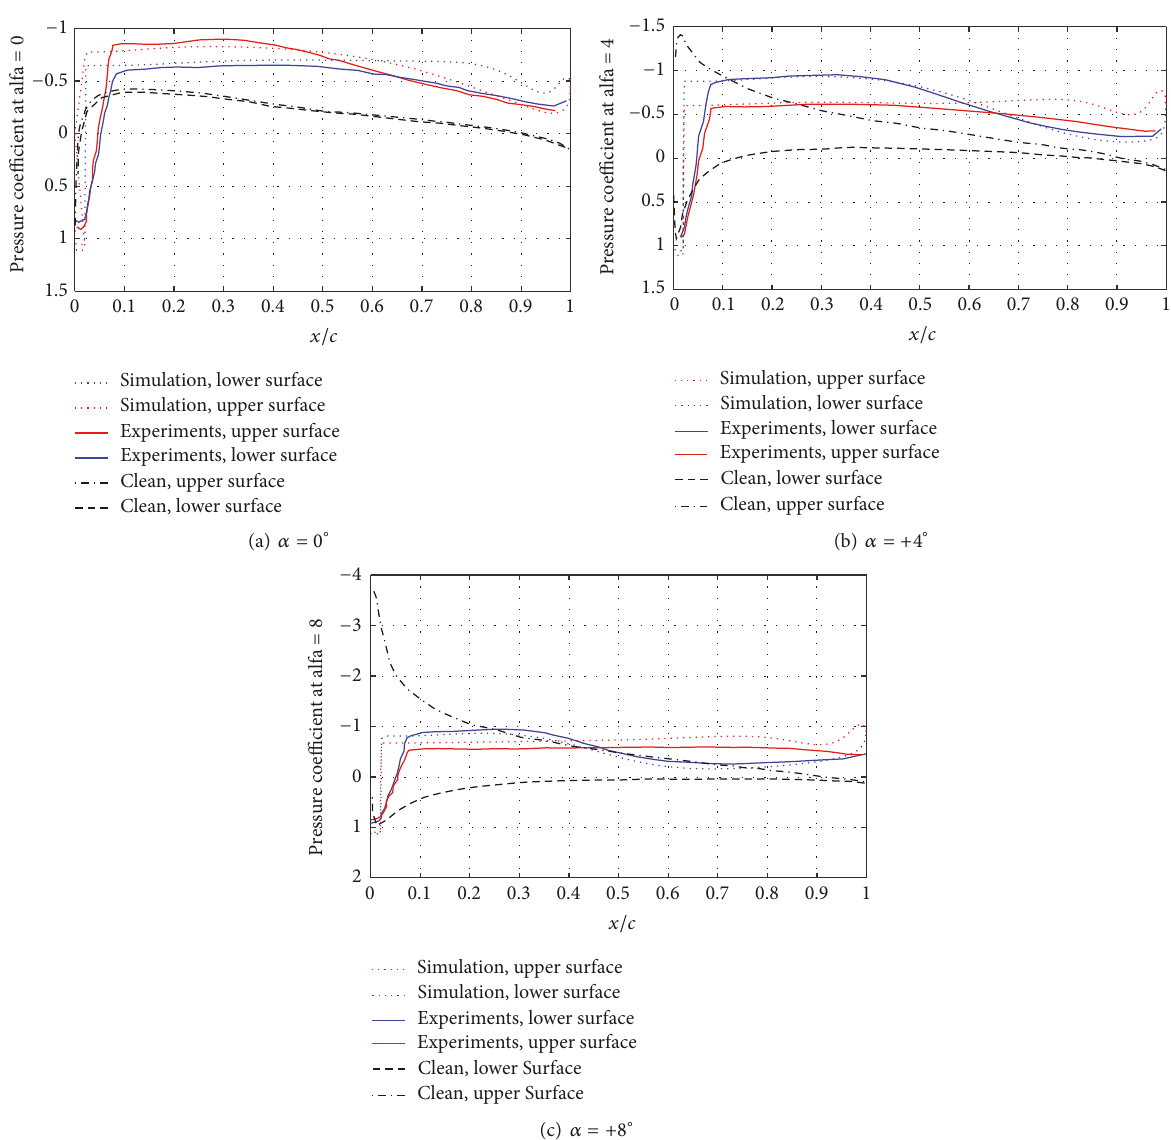
Figure 4: Surface pressures from leading edge to the trailing edge at different angles of attack (the experimental data of pressure distribution is available for only the three mentioned angles of attack) (scale of 𝑦 -axis is different to enable clarity in slope).